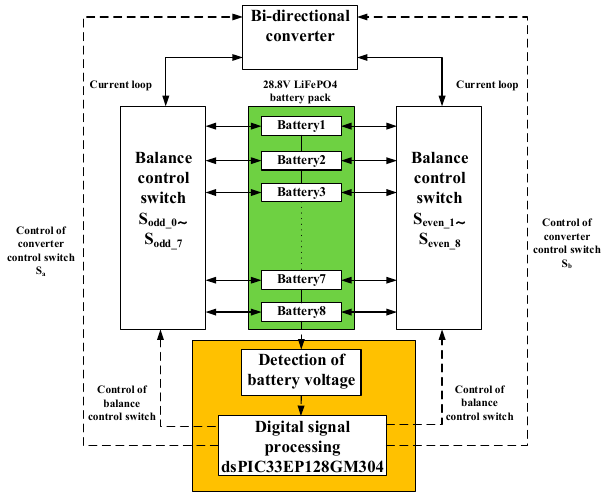
Figure 9. The structure of fast charging balancing circuit.